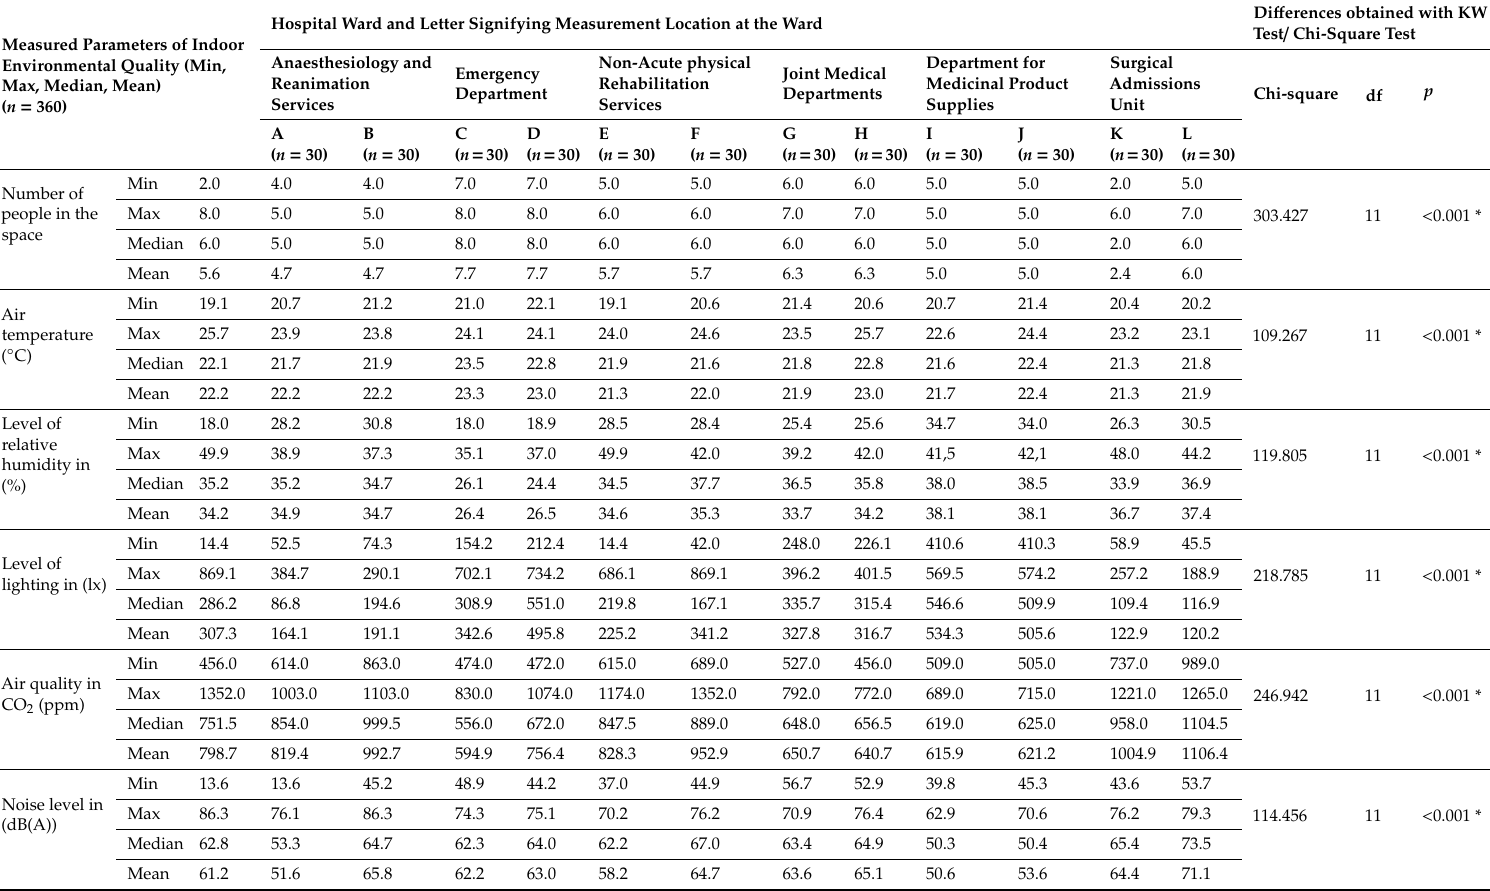
Table 3. Obtained indoor environmental quality parameters (min, max, median, mean) for the selected measurement locations of hospital wards (A–L).